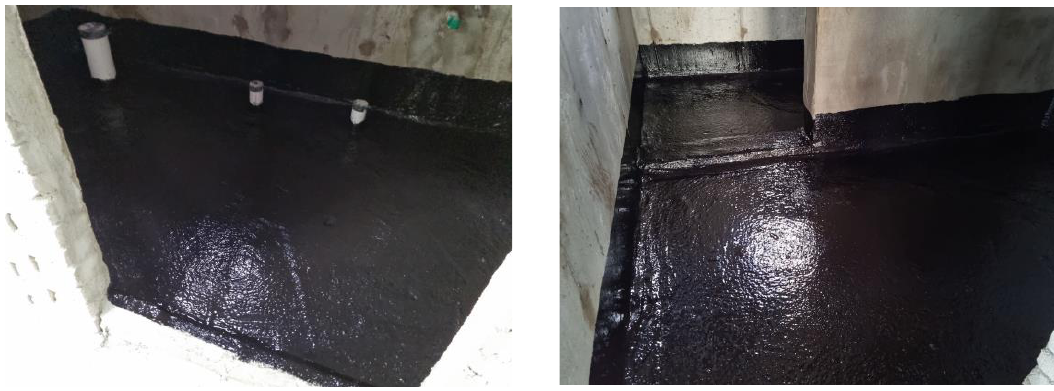
Figure 1. Water-soluble rubber-asphalt-based waterproof coating installation on floor.